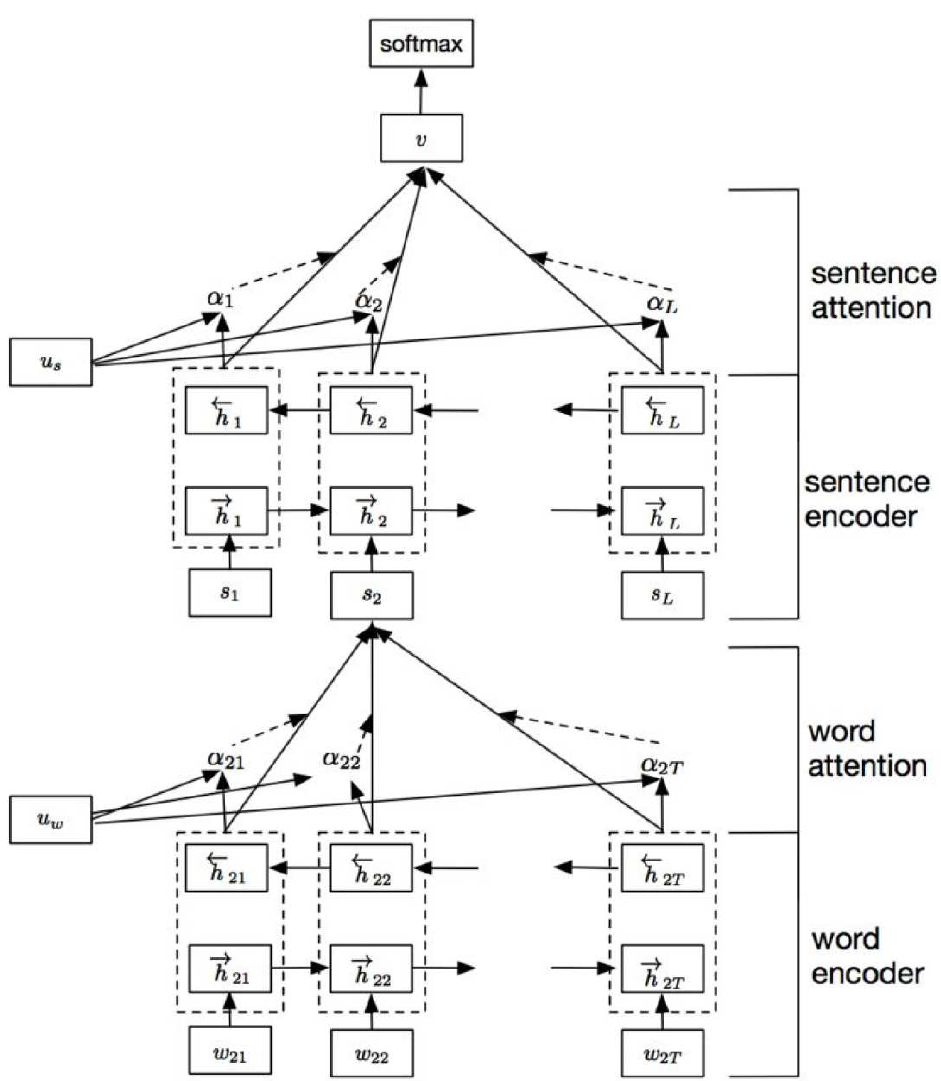
Fig. 5 Hierarchical attention